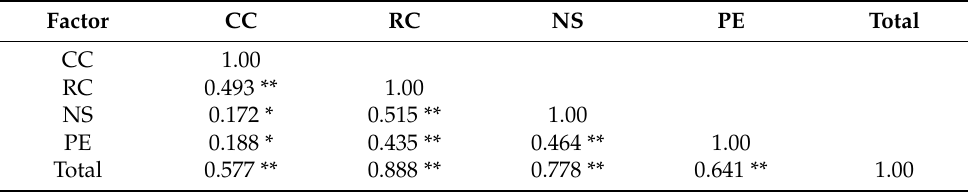
Table 4. The correlation matrix between the factors of the scale and total